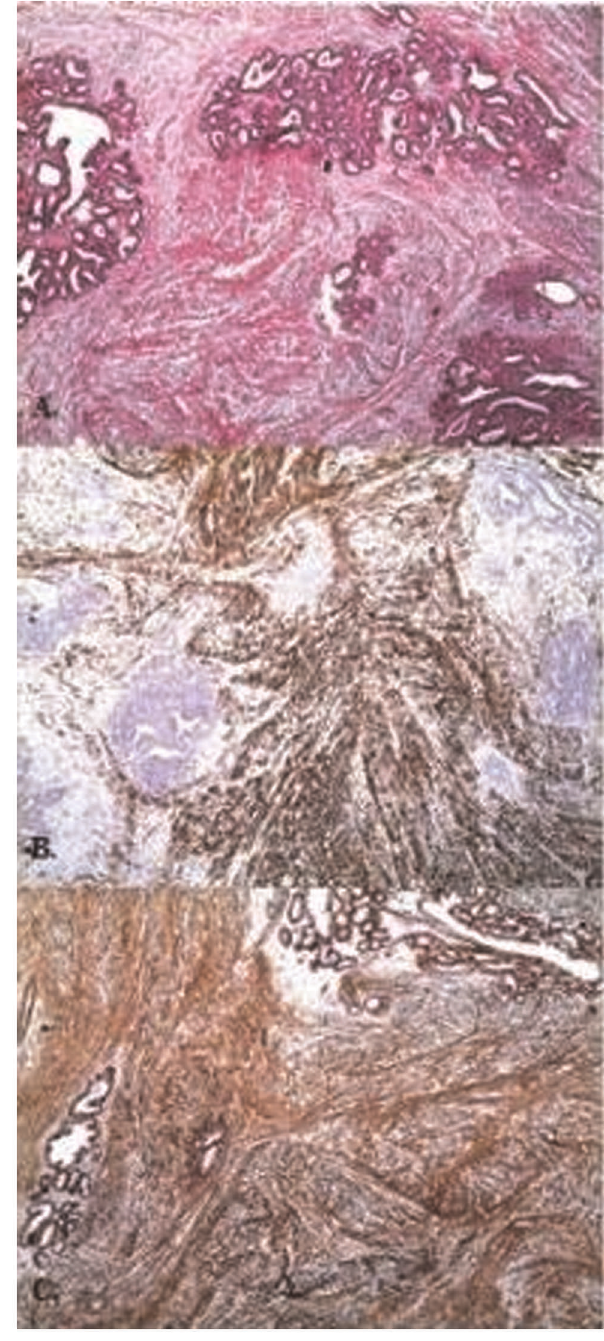
Figure 4 - Myoid hamartoma, (A) (H&E), 6 40 (B) desmin, 6 40, (C) SMA,